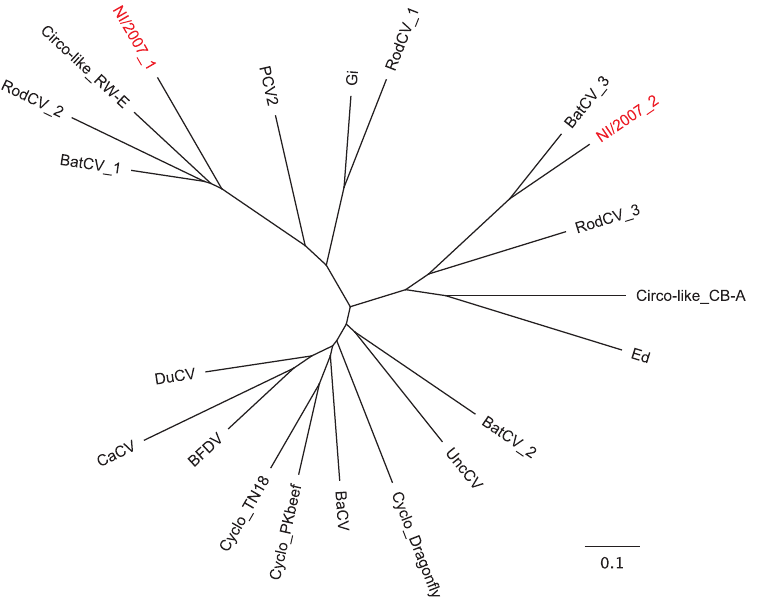
Figure 3. Circovirus-like NI sequence coverage and phylogeny. Phylogenetic neighbor-joining tree of amino acid sequences showing the relationship between Circovirus-like NI rep sequences (red) and 19 representative replicase sequences. Abbreviations: CV, circovirus, Ba, Barbel, Bat, Bat ZS/Yunnan-China/2009, BFDV, beak and feather disease virus, Ca, Canary Circo-like Circovirus-like genome, Cyclo, cyclovirus, PKbeef, PKbeef23/ PAK/2009, Du, Muscovy duck, Ed, Entamoeba dispar , Gi, Giardia intestinalis , PCV2, Porcine circovirus 2, RodCV, Rodent stool-associated circular genome virus, UncCV, uncultured circovirus. For a full list of sequences and accession numbers, see Table S2.